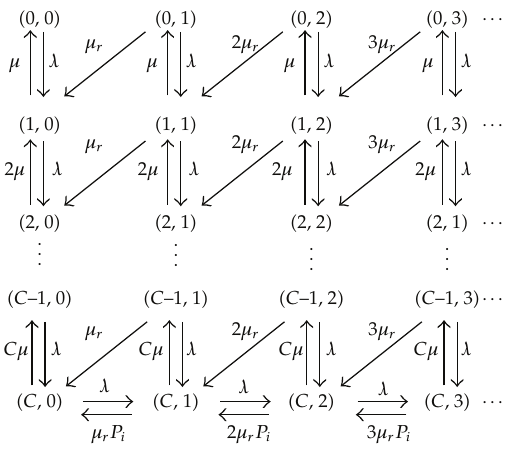
Figure 2: Transition